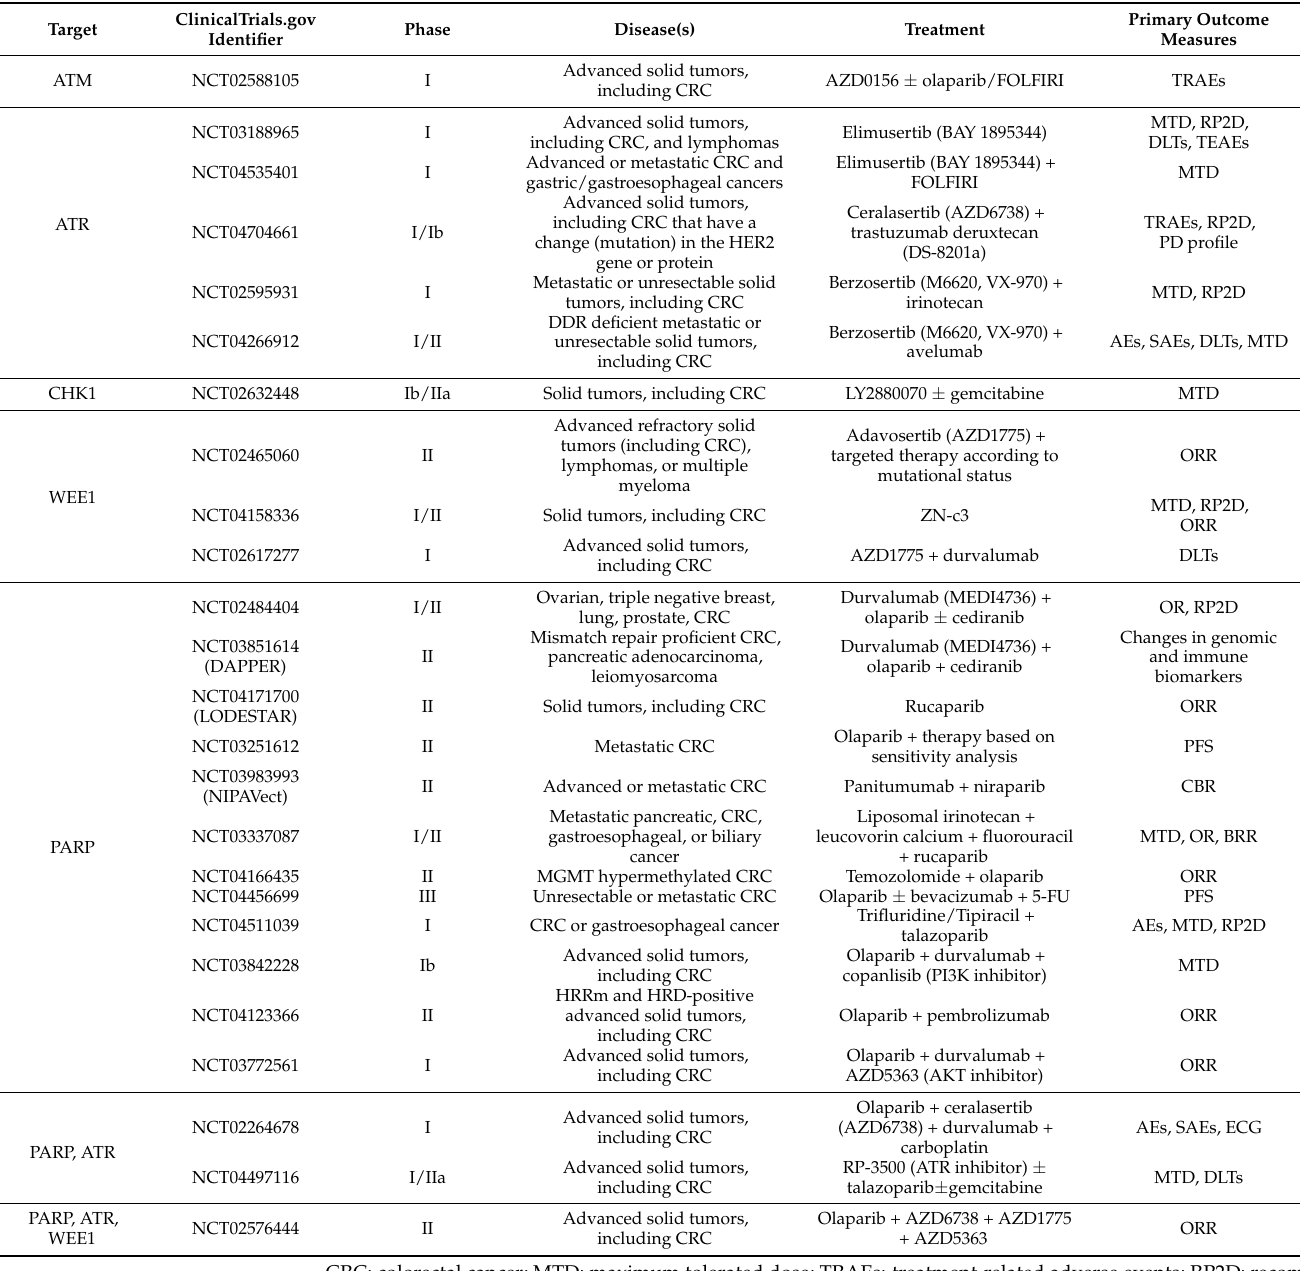
Table 3. Ongoing clinical trials evaluating the potential role of DDR and DNA repair pathways inhibitors monotherapy or combined with chemotherapy and/or immunotherapy in